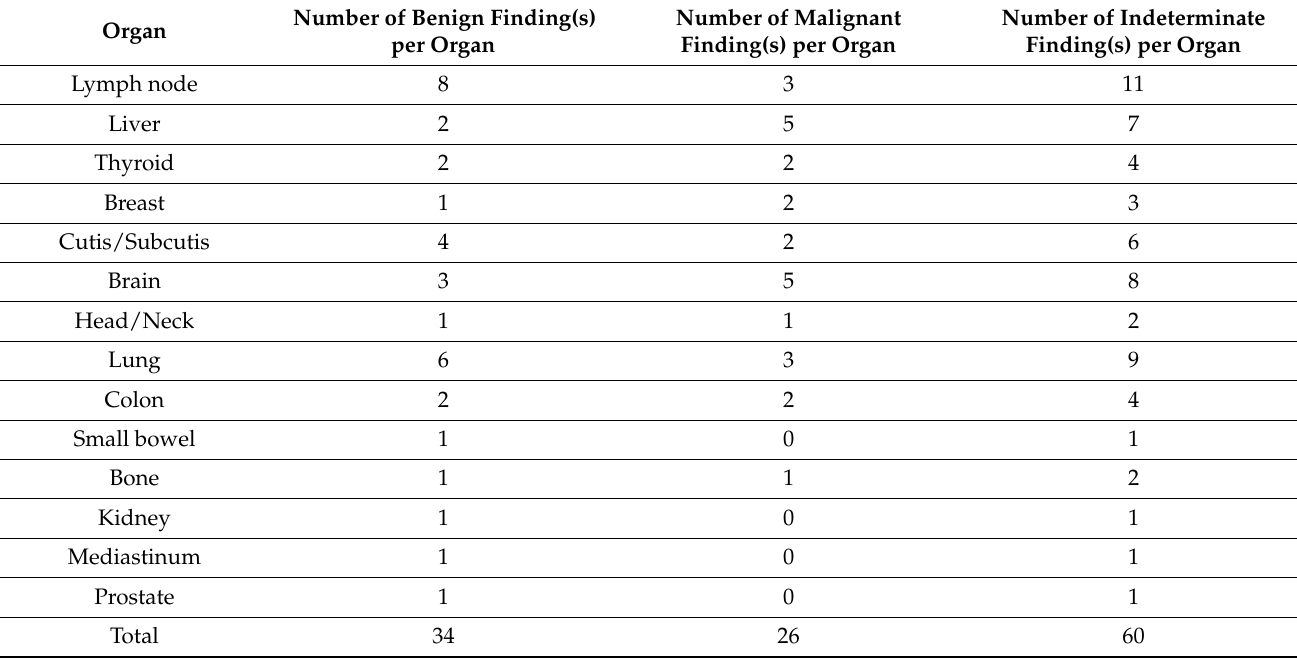
column from left) after further